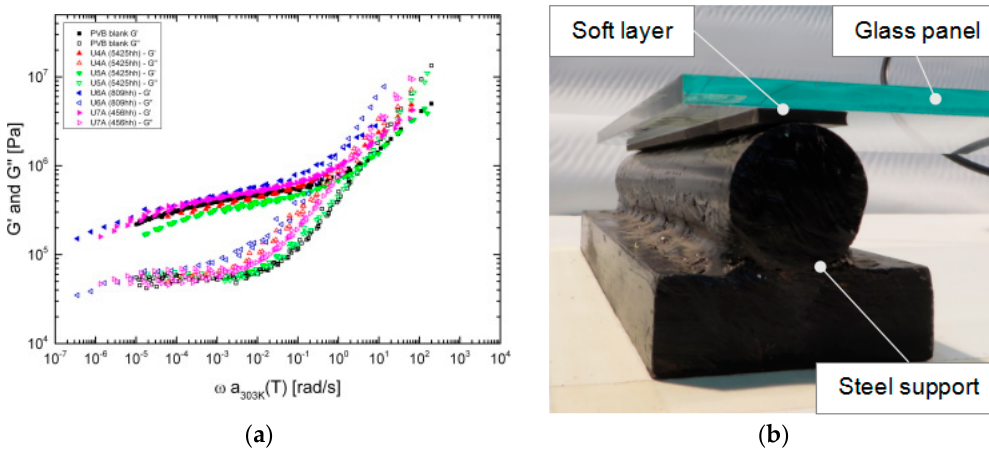
Figure 1. Dynamic performance of glass members: ( a ) Sensitivity of polyvinyl butyral (PVB®) stiffness to humidity / loading frequency (reproduced from [15] with permission from Elsevier, license n. 4585281507083, May 2019) and ( b ) flexible restraints (reproduced from [16] under CC BY 4.0 license).